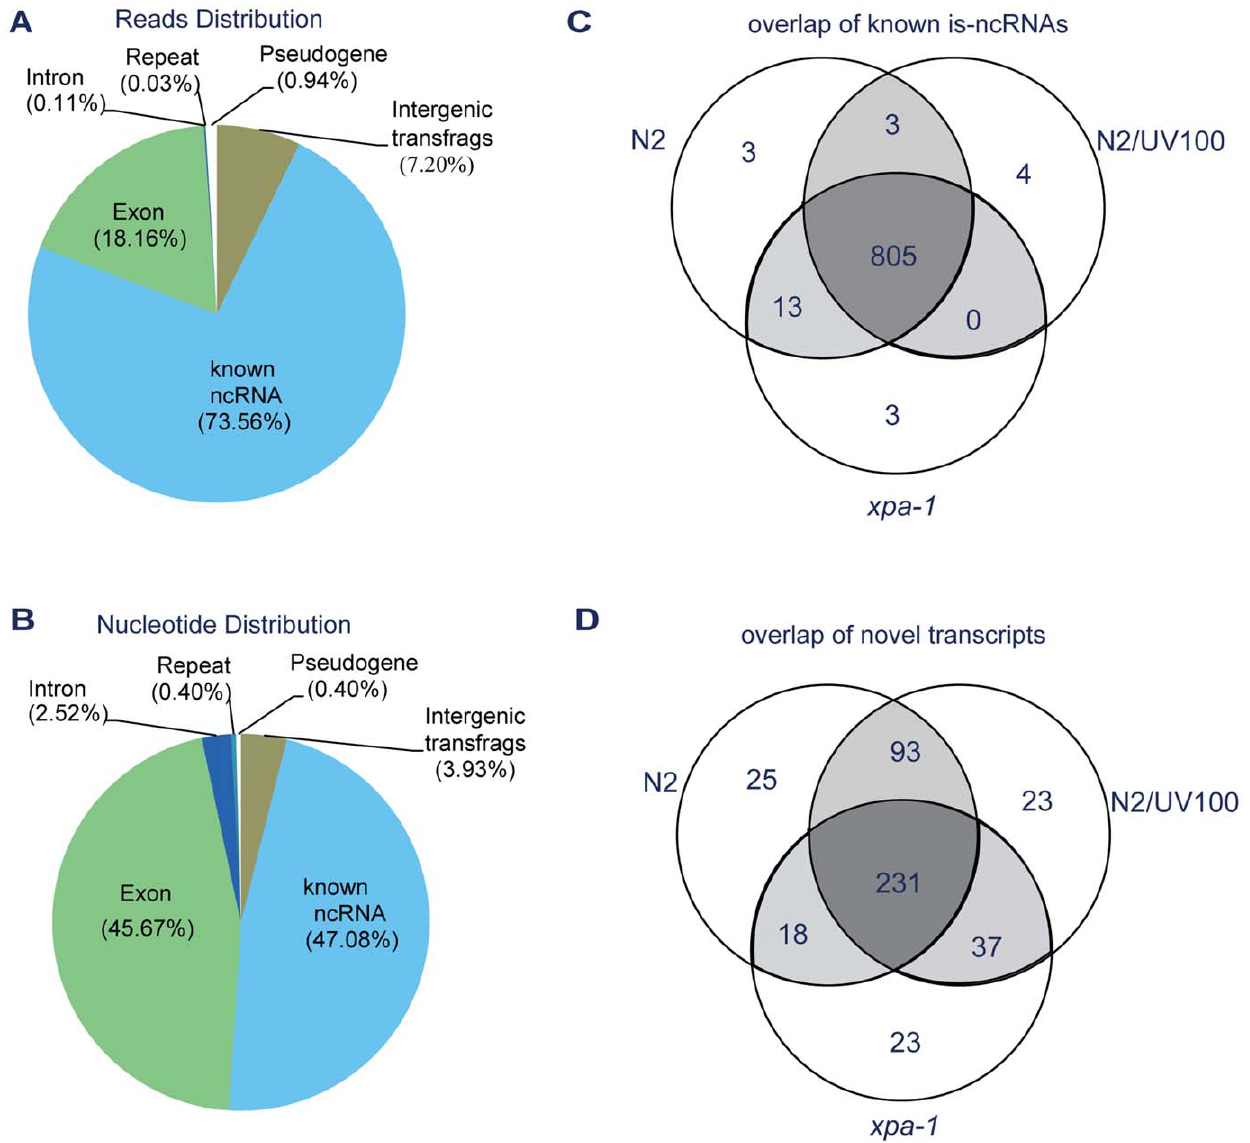
Figure 1. Sequencing data analysis. A and B, Genomic distribution of sequencing data. Average of control, UV-irradiated and xpa-1 deletion mutant samples. Reads were annotated either as ncRNAs, exons, introns, and pseudogenes and repeats, or as intergenic. (A) Reads distribution. The score for reads that mapped to multiple genomic loci was averaged according to the number of hits. (B) Distribution of genomic nucleotides covered by at least one sequencing read. C and D, Overlap of known is-ncRNAs (E) and novel transcripts (F) in the three RNA-Seq